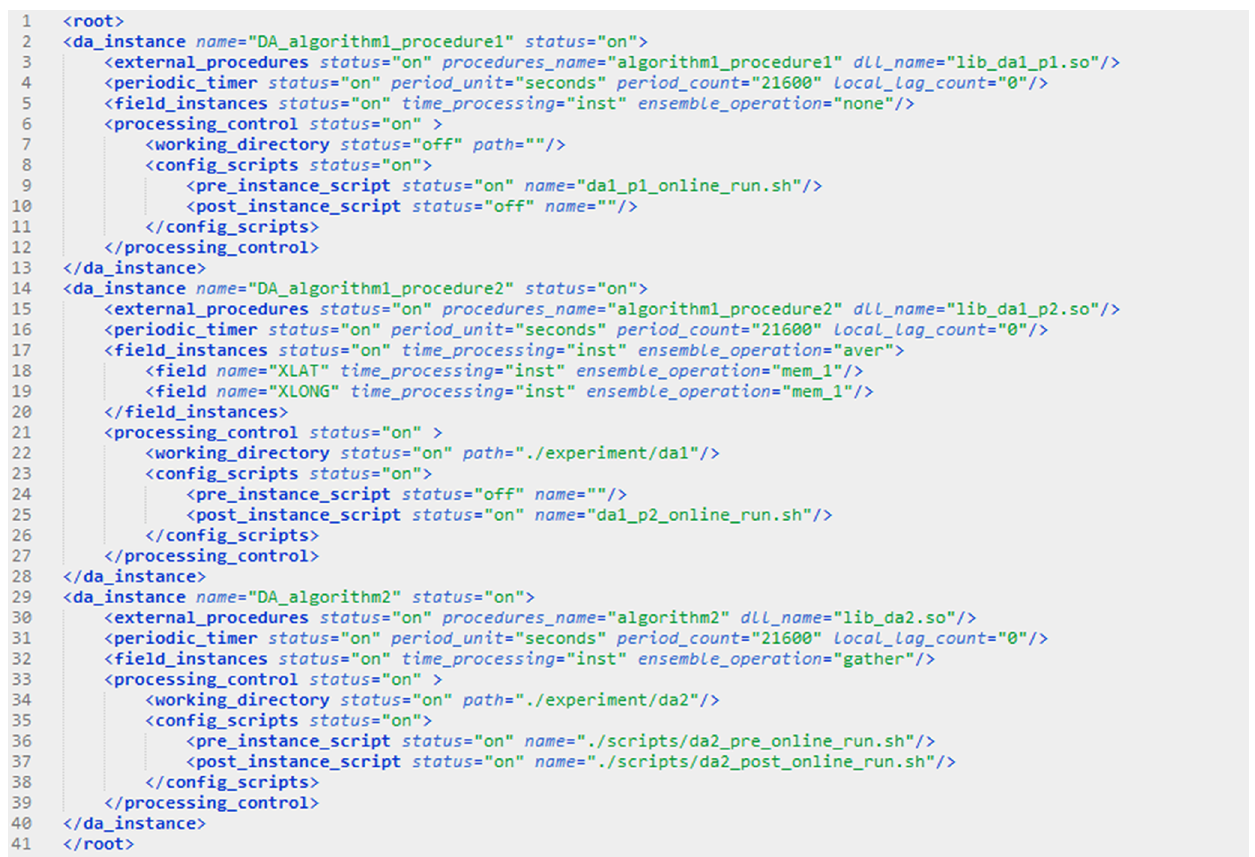
Figure 7. Example of the XML configuration for a DA